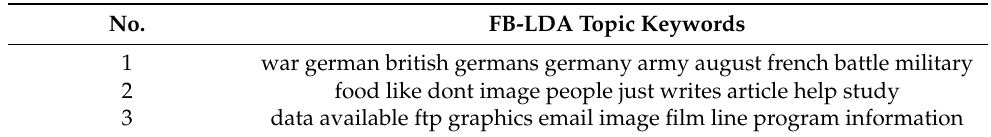
Table 7. FB-LDA (K = 3) results for 10 Newsgroups dataset.